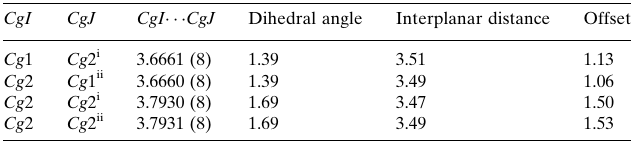
Table 2 (cid:2) – (cid:2) interactions (A˚ , (cid:1) ). Cg 1 and Cg 2 are the centroids of rings O1/C2–C4/C4 A –C8 A and C4 A /C5–C8/ C8 A , respectively. The offset is defined as the distance between CgI and the perpendicular projection of CgJ on ring I